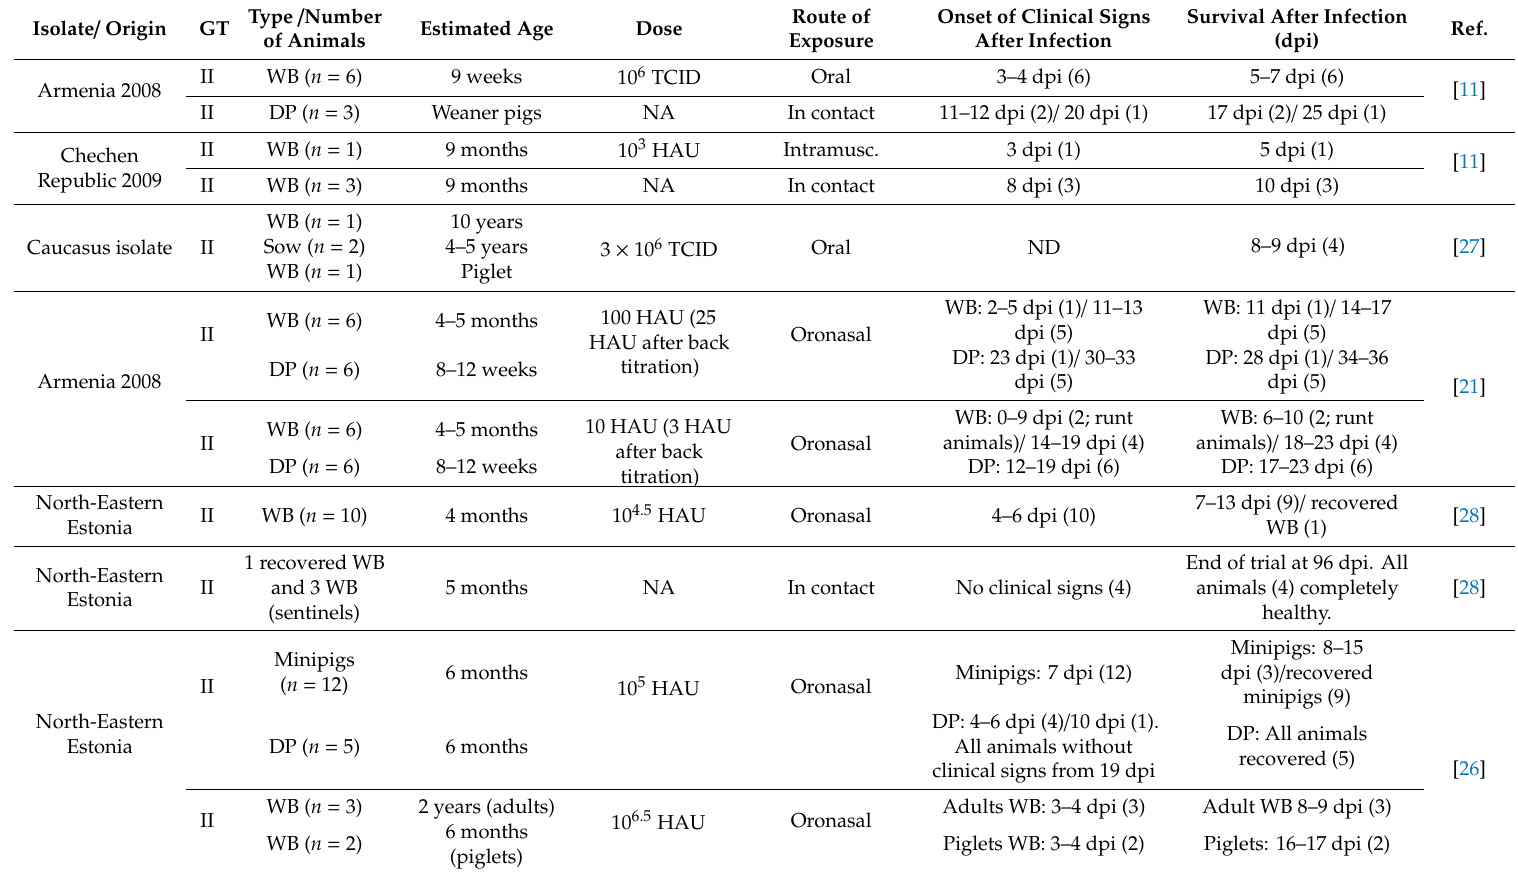
Table 1. Experimental infections of wild boar with African swine fever virus (ASFV) Genotype II isolates. Information about experimental conditions of domestic pigs that were infected in parallel with wild boar have also been provided. (GT): genotype; (WB): wild boar; (DP): domestic pigs; (HAU): haemagglutinating units; (TCID): Tissue Culture Infectious Dose (TCID), (ND): Not determined; (NA): Not administered (in contact